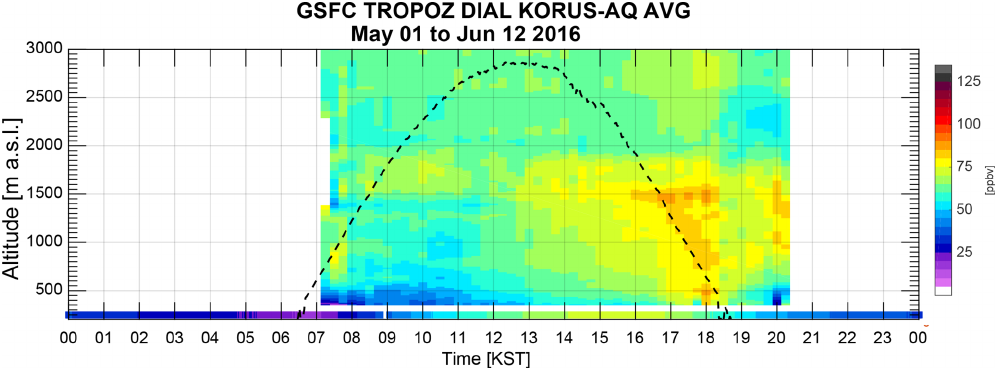
Figure 12. Composite averaged curtain of GSFC TROPOZ DIAL observations during the KORUS-AQ study period. This comprises 31 days of lidar data and over 250h of measurements averaged together, and the analogous surface measurements and solar curve proxy are also